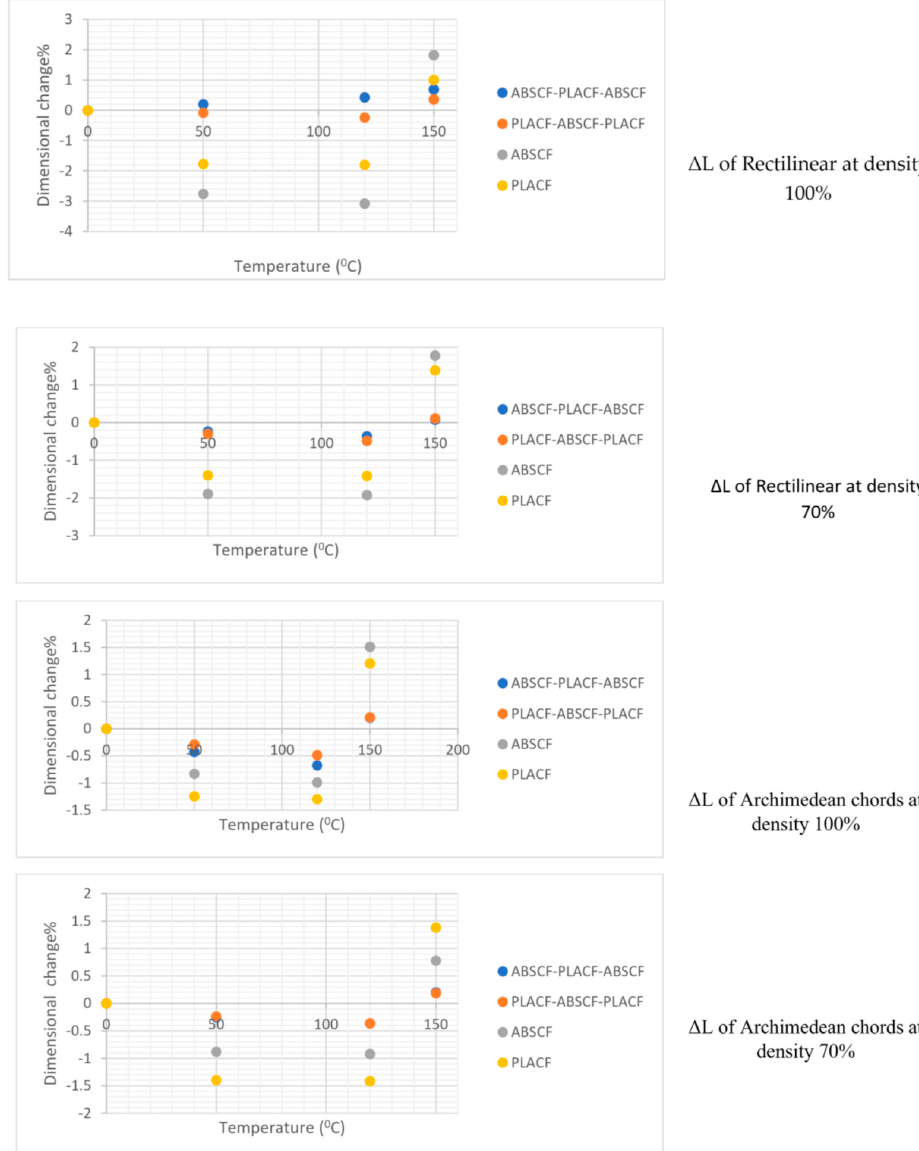
Figure 4. Relative change values of width (L) for the samples under different heat-treatment conditions.